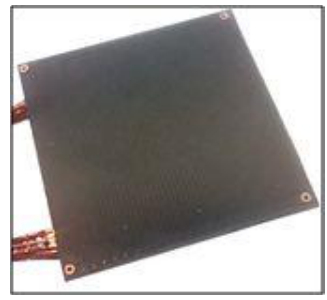
Fig. 6. Custom made heated element.